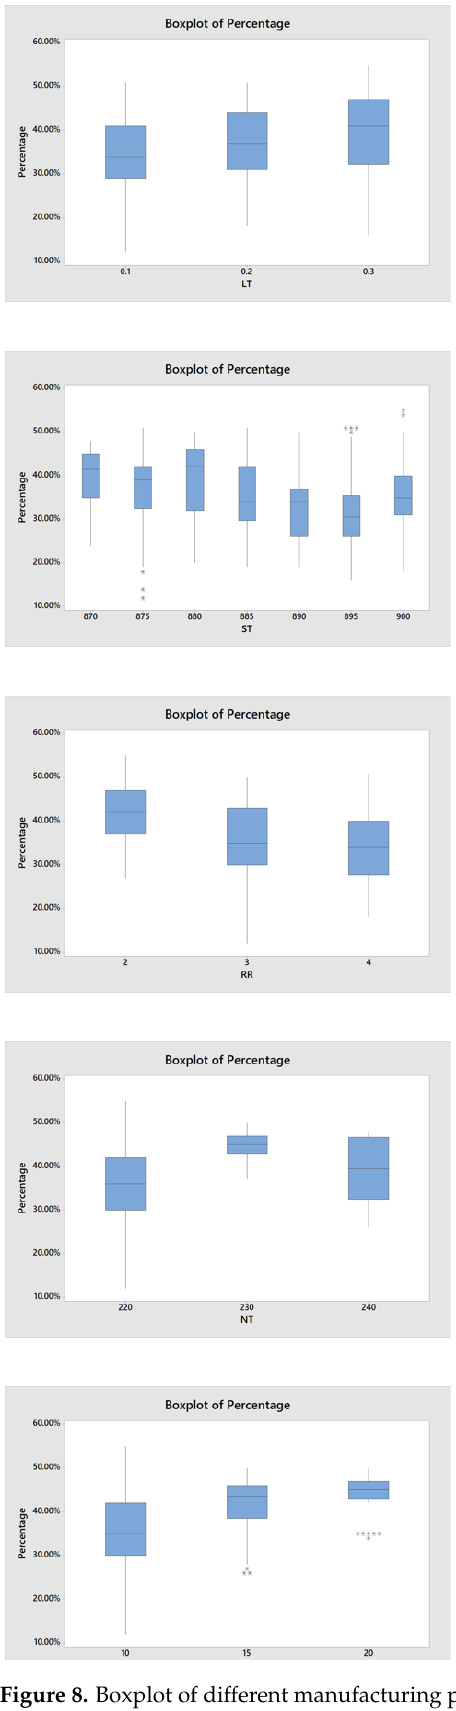
Figure 8. Boxplot of different manufacturing parameters on void percentage.